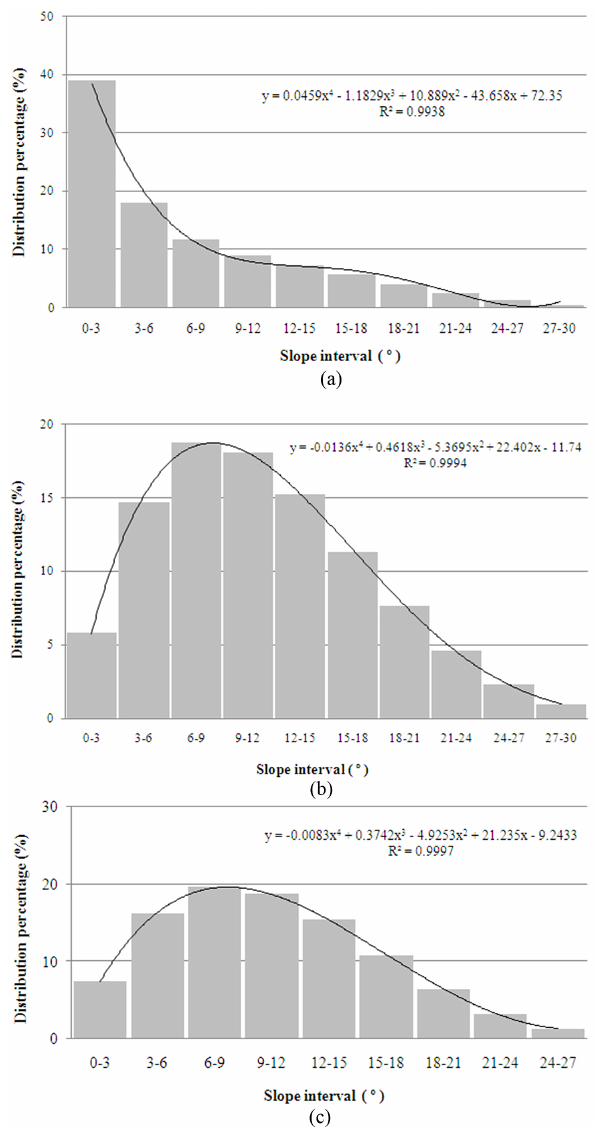
Figure 6. Slope spectrum and its quantitative analysis for the typi- cal loess geomorphologic types. (a) Loess tableland, (b) loess ridge and (c) loess knoll.